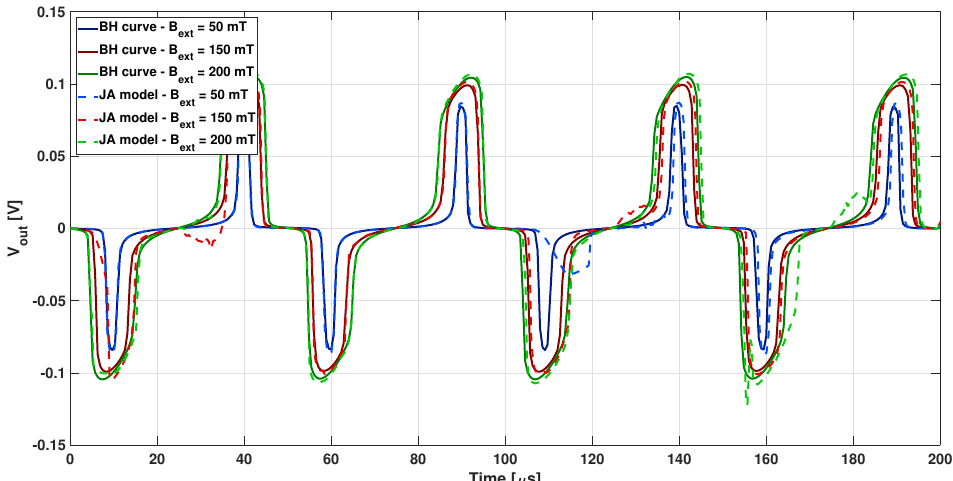
Figure 13. Differential output voltage calculated by adopting the parameters related to the JA1 loop (dotted lighter lines), for three values of the external magnetic field (50, 150, and 200 µ T), compared to the related ones calculated with the corresponding BH characteristic (continuous darker lines).